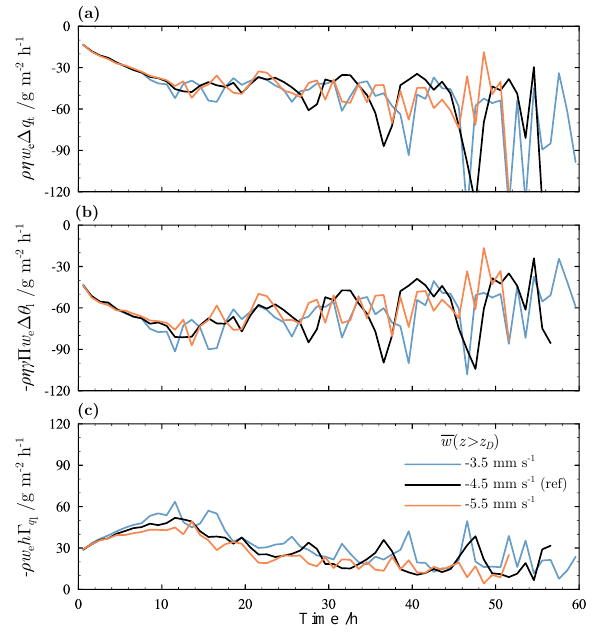
Figure 7. The LWP tendency due to entrainment split up into the three terms of Eq. (5): (a) entrainment drying, (b) entrainment warming and (c) cloud deepening due to entrainment.